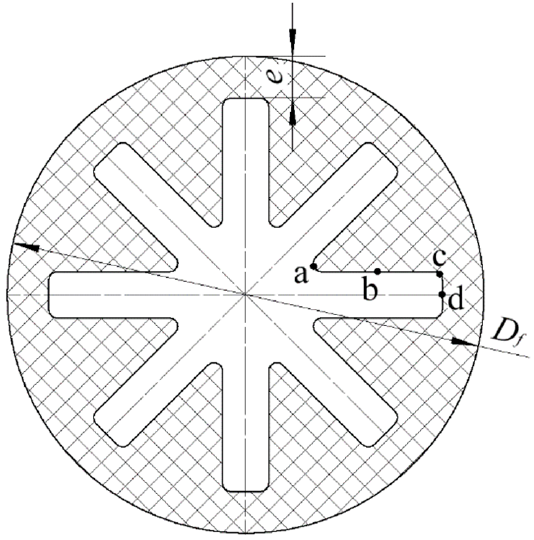
Figure 2. The cross section in the middle of star grain.